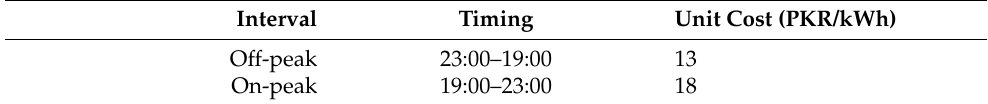
Table 2. Off-grid